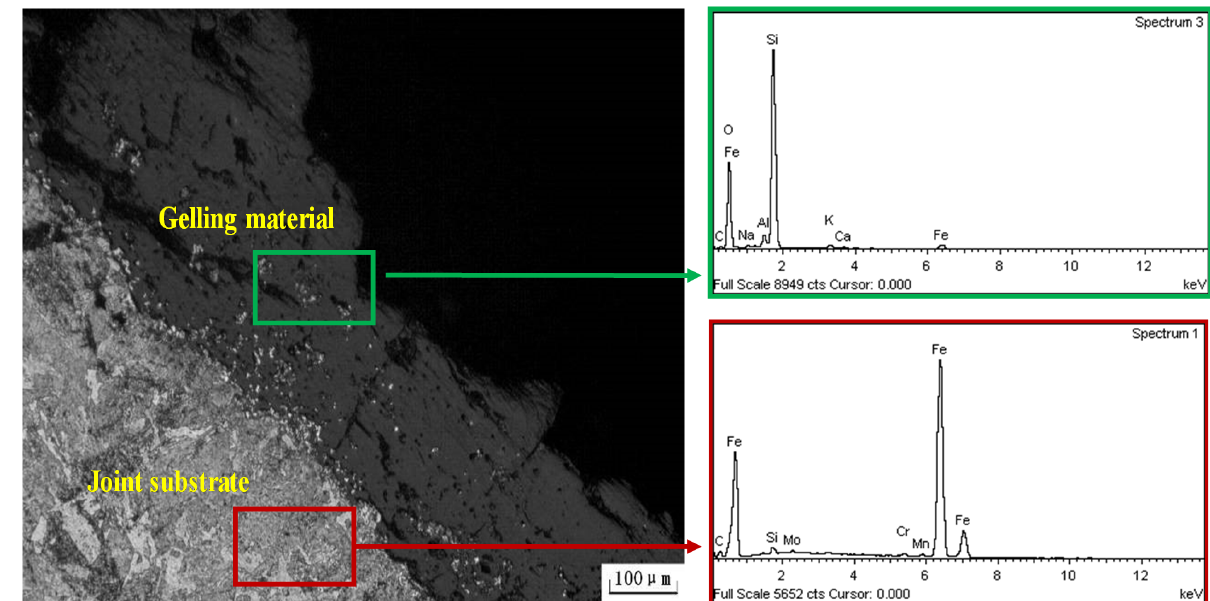
Figure 6. Energy spectrum analysis results of fracture location.